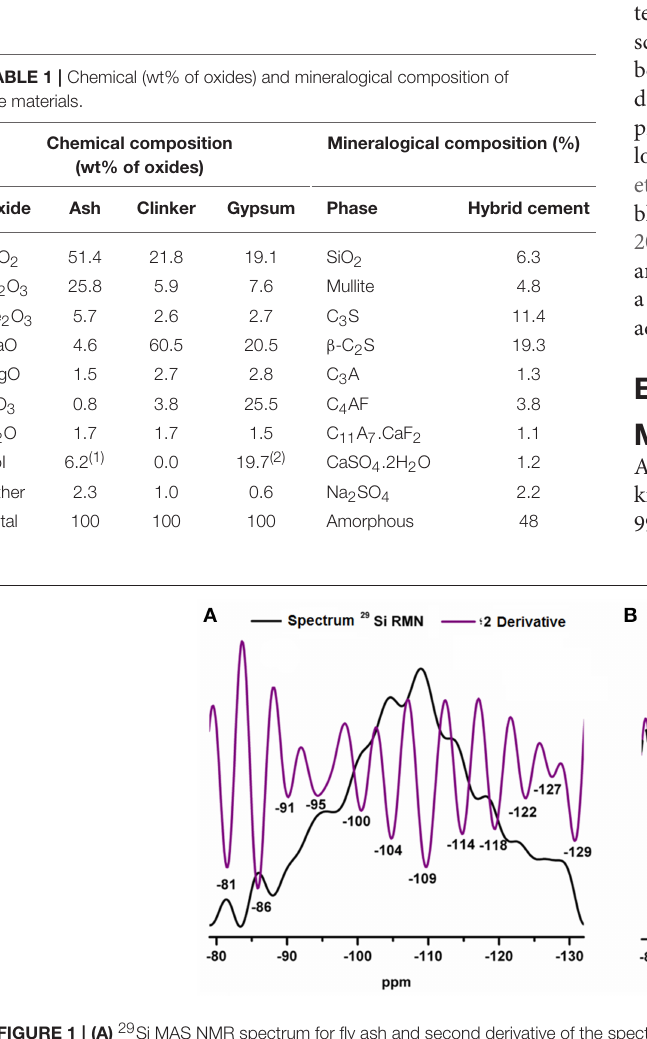
FIGURE 1 | (A) 29 Si MAS NMR spectrum for fly ash and second derivative of the spectrum; (B) second derivatives of the original 29 Si MAS NMR spectrum for fly ash and of the envelope generated by